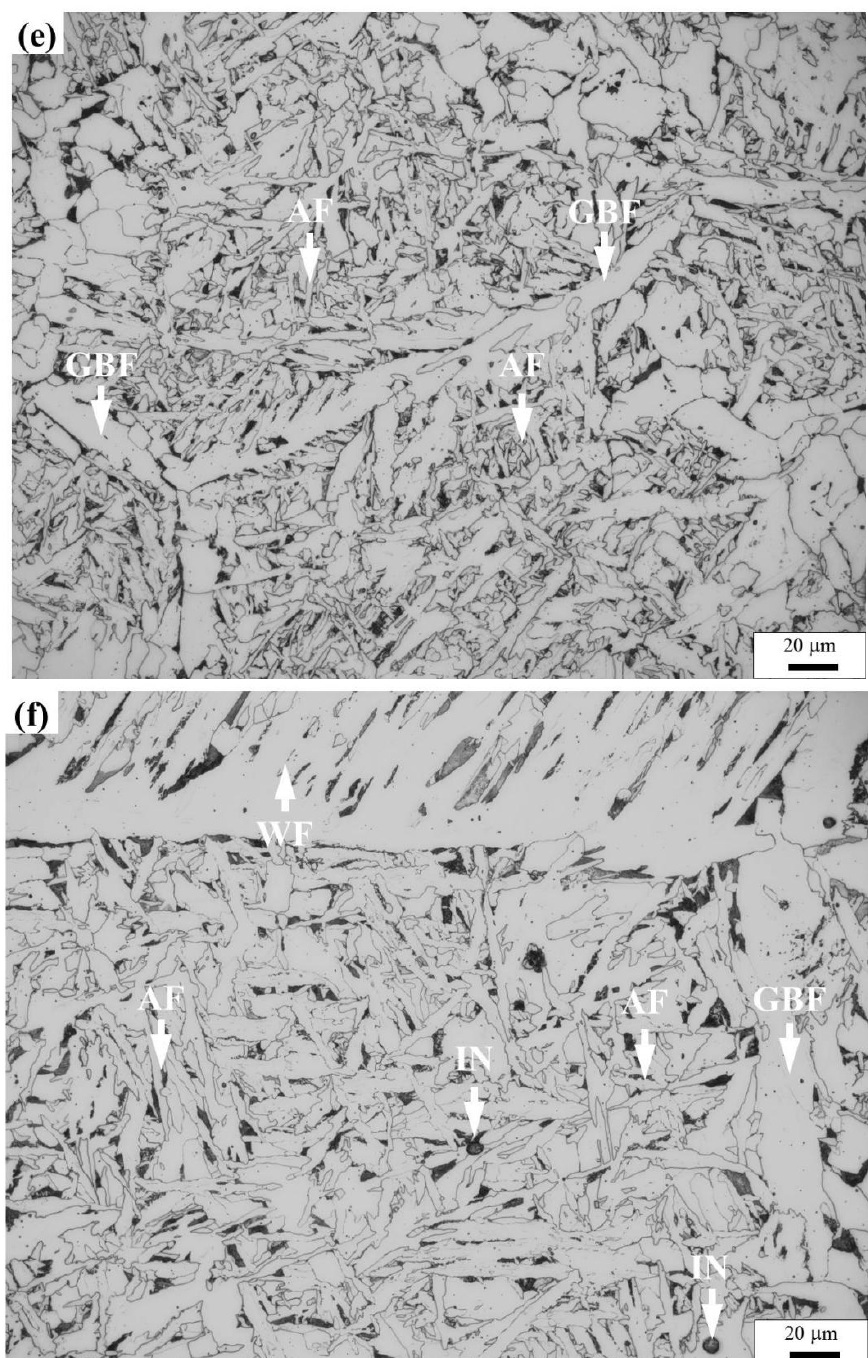
Figure 2. Typical microstructure of air-cooled base metal ( a ), CGHAZ with 100 kJ/cm in air-cooled initial microstructure ( b ), and CGHAZ with 400 kJ/cm in air-cooled initial microstructure ( c ), water-quenched base metal ( d ), CGHAZ with 100 kJ/cm in water-quenched initial microstructure ( e ), and the CGHAZ with 400 kJ/cm in water-quenched initial microstructure ( f ). P indicates pearlite, which is the back-etching grains; PF indicates polygonal ferrite, which mostly are equiaxed grains; M indicates martensite, which are thin laths; AF indicates acicular ferrite, which is ferrite that formed by combination of shear and displacive mechanism as sharp needles; GBF indicates grain boundary ferrite; WF indicates Widmanstatten ferrite; and IN indicates inclusions.